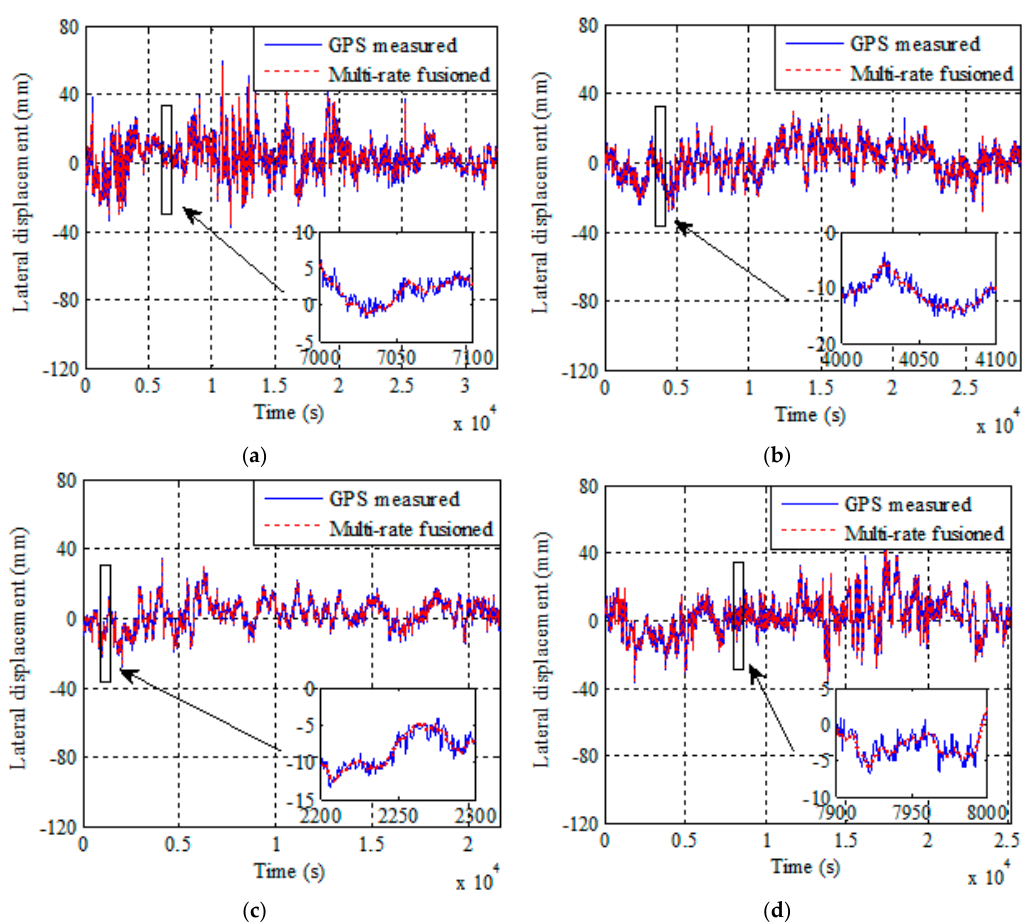
Figure 6. Global Positioning System (GPS) measured displacements and improved multi-rate fusion displacement results from Cases 1–4. ( a ) Case 1. ( b ) Case 2. ( c ) Case 3. ( d ) Case 4.